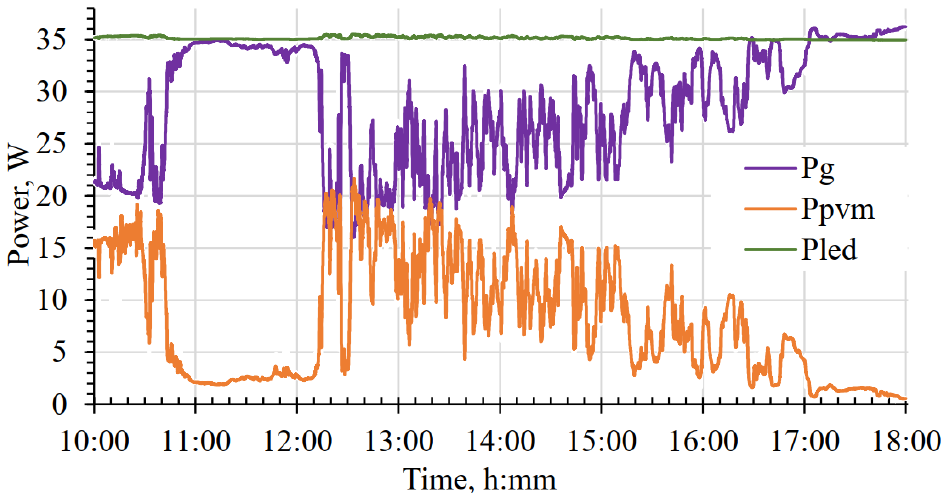
Figure 6. Voltages on the elements of LED lighting system: (U PVM ) voltage at the output of the PVM converter; (U grid ) voltage at the output of the grid converter; (U LED ) voltage at the input of the LED current supply.